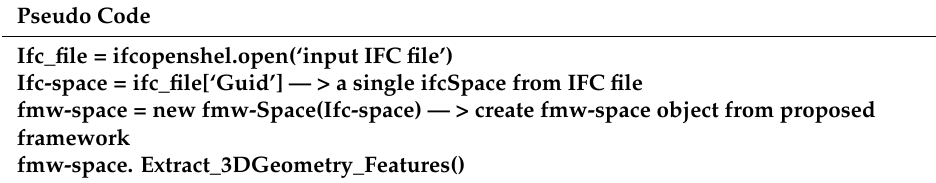
Table 2. A pseudocode description of initializing the fmw-space